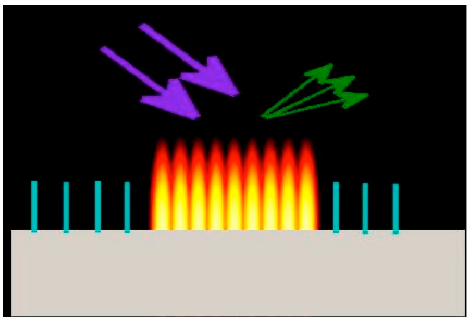
Figure 11. Cartoon indicating how a laser beam interacts with snow pillars about 100 μm in size. The laser may interact with one or more pillars (purple arrows) and the protons come off (green arrows) from the target on the same side from which the laser approaches the target. This is not a TNSA process